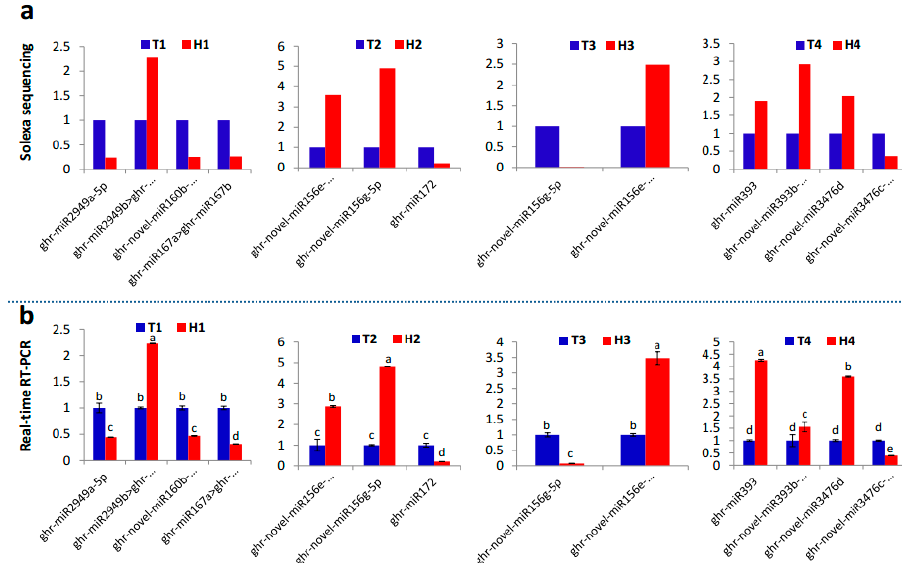
Figure 5. qRT-PCR validation of the main HT responsive miRNAs identified by small RNA sequencing. ( a ) Fold-change of miRNAs at the four developmental stages under HT stress based on small RNA sequencing data. ( b ) The relative expression of the same miRNA members under HT stress detected by qRT-PCR and represented as means of three replicates ( n = 3) ± standard error. Significant di ff erences indicated with letters above each bar ( p ≤